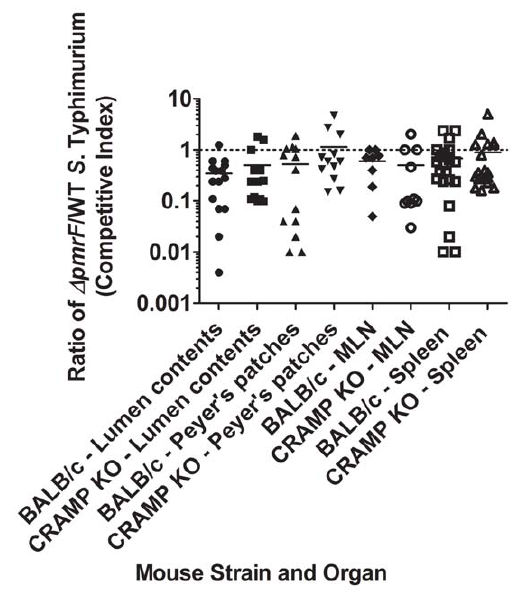
Figure 4. Survival of WT and D pmrFS. Typhimurium in BALB/c and CRAMP KO mice. BALB/c (WT) and background-matched CRAMP KO mice were infected via the oral route with a 1:1 mixture of WT S . Typhimurium and D pmrF bacteria containing 10 8 CFU of each strain. Bacteria were recovered from the lumen contents, Peyer’s patches, mesenteric lymph nodes (MLN) and spleen from 24 BALB/c and 22 CRAMP KO mice 96 hrs. p.i. Graphed values represent the competitive index (CI) ratio (output ratio/input ratio) of D pmrF/ WT bacteria recovered from each mouse organ ( Salmonella was not recovered from each organ). Each value graphed as the same shape represents the CI ratio calculated from the specified organ of one WT or CRAMP KO mouse. There are no significant differences between any of the observed average CI ratios (p $ 0.05).